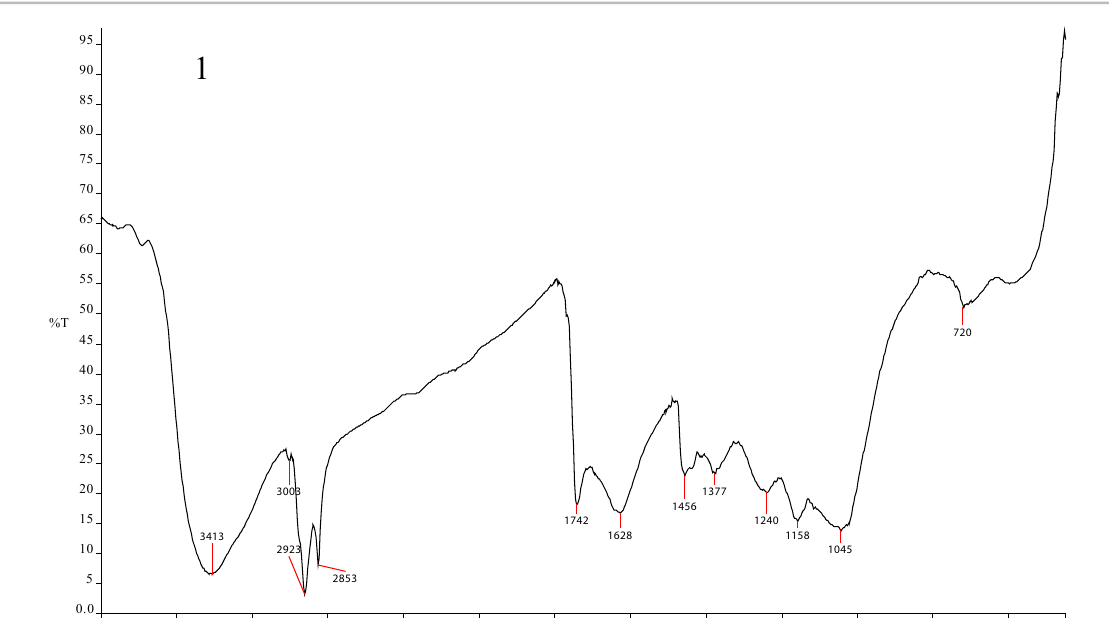
FIGURE 4 - FTIR Spectrum of M. arvensis Linn. mediated silver nanoparticles. [Spectrum showing peaks corresponding to different functional chemical groups of